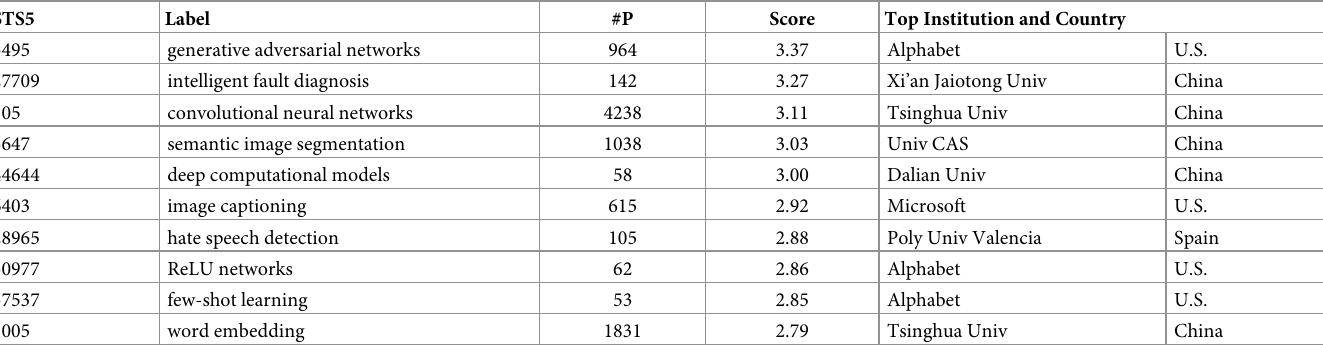
Table 10. Top 10 forecasted STS5 RCs (FY = 2018) from the Computing Technology